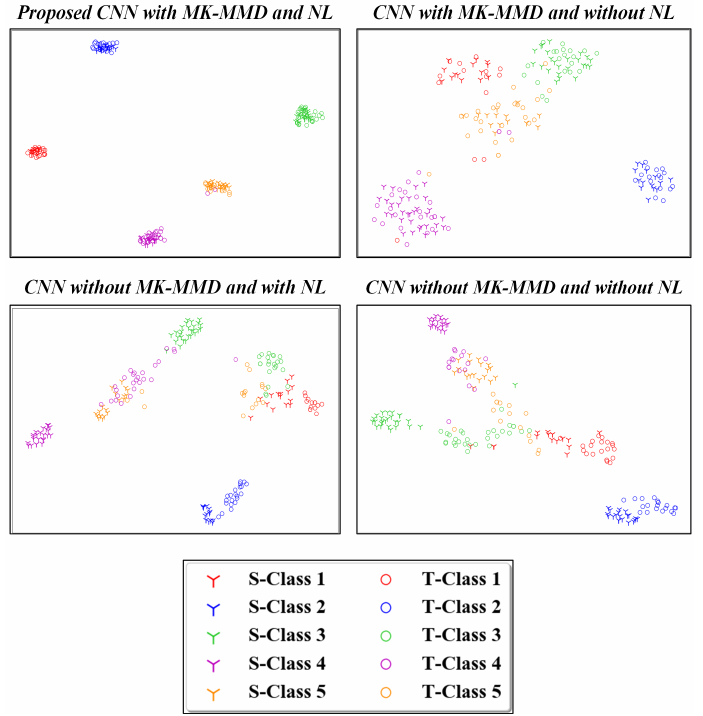
Figure 12. Visualization results of high-level features in the fully connected layer by different methods. S - and T -denotes source and target domains, respectively. Task T 5 of the Paderborn dataset is focused